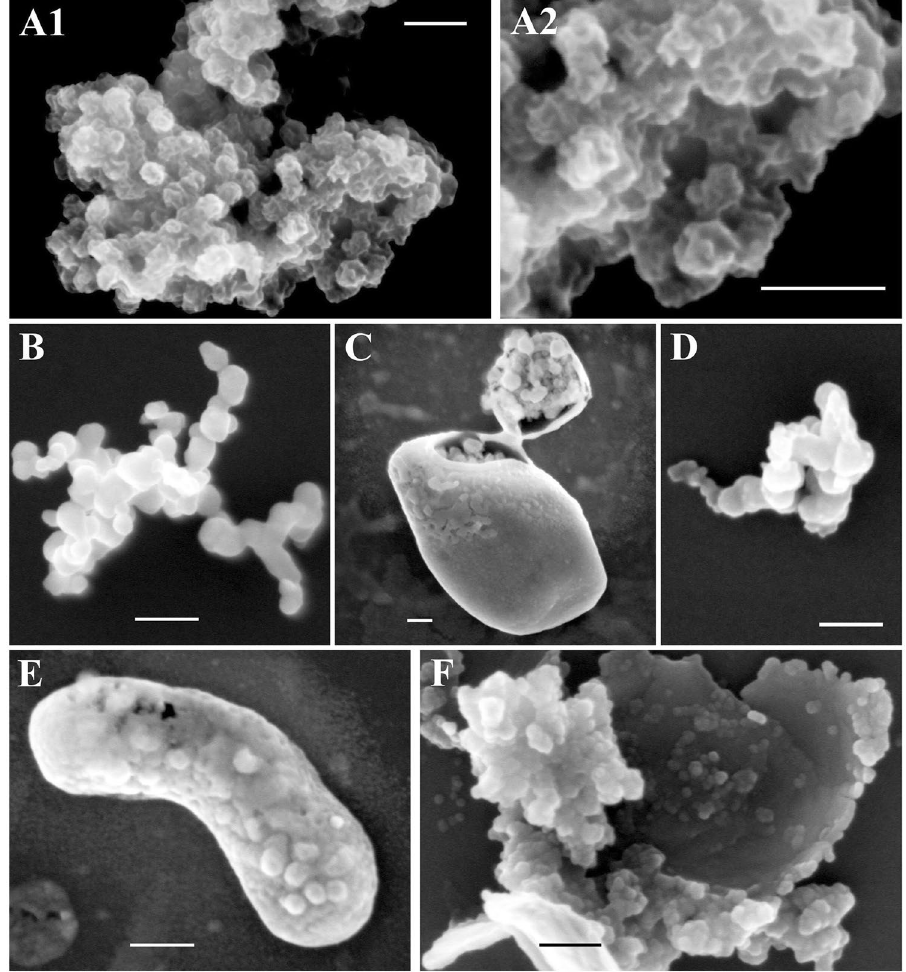
Figure 6. Focused ion beam scanning electron microscope (FIB-SEM) observation of NNV particle’s surface structures. Purified NNV particles were treated at 45 °C for 24 h or at 100 °C for 5 min and subjected to FIB- SEM. ( A1 ) and ( A2 ) Purified NNV particles without heat-treatment, ( B–C ) Purified NNV particles with heat- treatment at 45 °C for 24 h, ( D–F ) Those treated at 100 °C for 5 min. Scale bars = 100